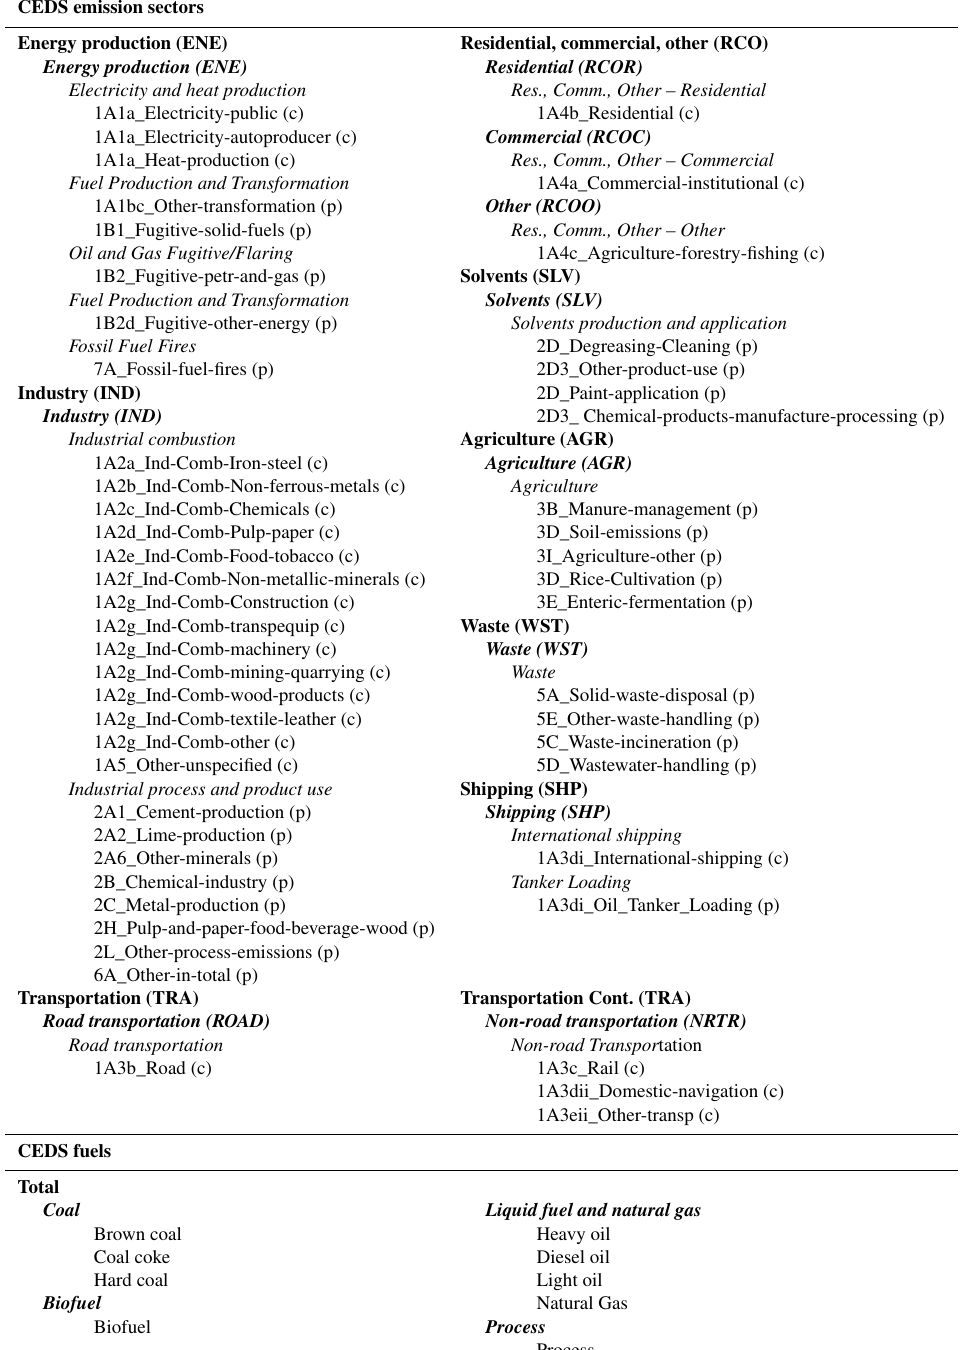
Table 2. CEDS sector and fuel type definitions. Aggregate sectors and fuel types in the CEDS Hoesly (bold) and CEDS GBD − MAPS (bold and italic) inventories as well as the system’s intermediate gridding sectors (italic) and detailed working sectors and fuel types (consistent between CEDS Hoesly and CEDS GBD-MAPS inventories). CEDS working sectors are methodologically treated as two different categories: combustion sectors (c) and “process” sectors (p). As described in the text, combustion sector emissions are calculated as a function of CEDS working fuels, while process emissions are assigned to the single “process” fuel